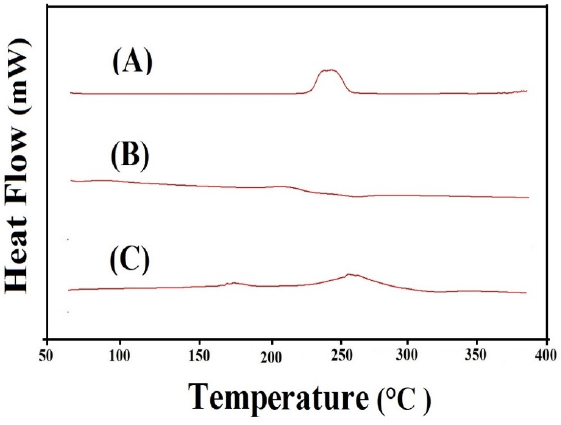
Figure 6. DSC of ( A ) Aspartic acid (ASP), ( B ) Alginate (AL), and ( C ) ASP/ALPAA